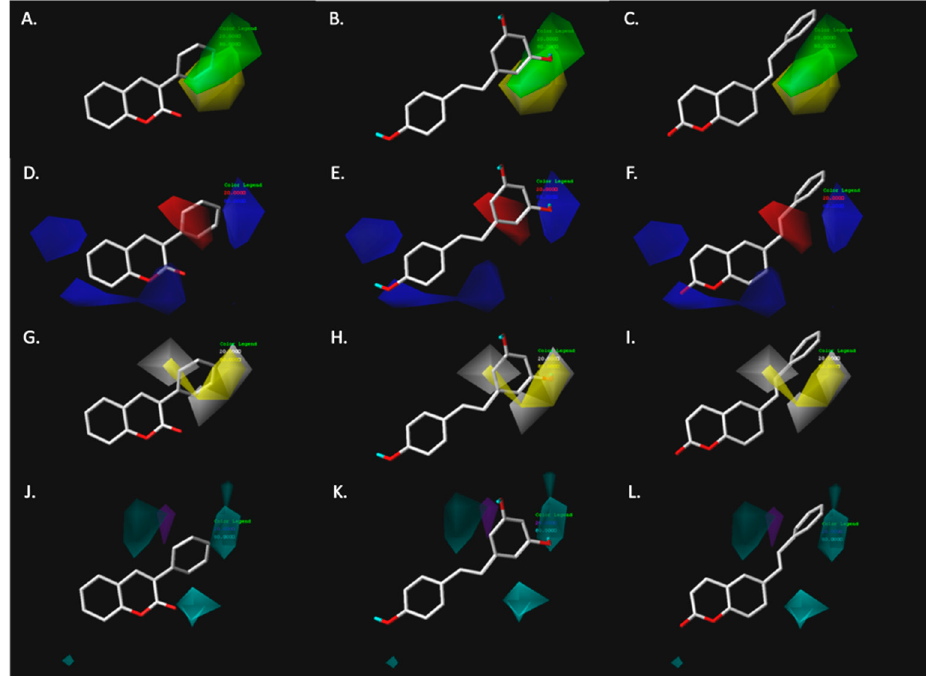
Figure 7. Overlay of 3-phenylcoumarin, trans -resveratrol and trans -6-styrylcoumarin on the contour map obtained from the MAO-B CoMSIA model. ( A ) trans -Resveratrol and steric map. ( B ) 3-Phenylcoumarin and steric map. ( C ) trans -6-Styrylcoumarin and steric map. ( D ) trans -Resveratrol and electrostatic map. ( E ) 3-Phenylcoumarin and electrostatic map. ( F ) Trans -6-styrylcoumarin and electrostatic map. ( G ) trans -Resveratrol and hydrophobic map. ( H ) 3-Phenylcoumarin and hydropho- bic map. ( I ) Trans -6-styrylcoumarin and hydrophobic map. ( J ) trans -Resveratrol and hydrogen-bond donor map. ( K ) 3-Phenylcoumarin and hydrogen-bond donor map. ( L ) trans -6-Styrylcoumarin and hydrogen-bond donor map. Color code: steric contour map green—bulky groups are favorable for the activity; steric contour map yellow—small groups are favorable for the activity; electrostatic contour map red—negative charge is favorable for the activity; electrostatic contour map blue— positive charge is favorable for the activity; hydrophobic contour map yellow—hydrophobic groups are favorable for the activity; hydrophobic contour map grey—hydrophilic groups are favorable for the activity; hydrogen-bond donor map cyan—hydrogen-bond donor groups are favorable for the activity; hydrogen-bond donor map purple—hydrogen-bond donor groups are unfavorable.